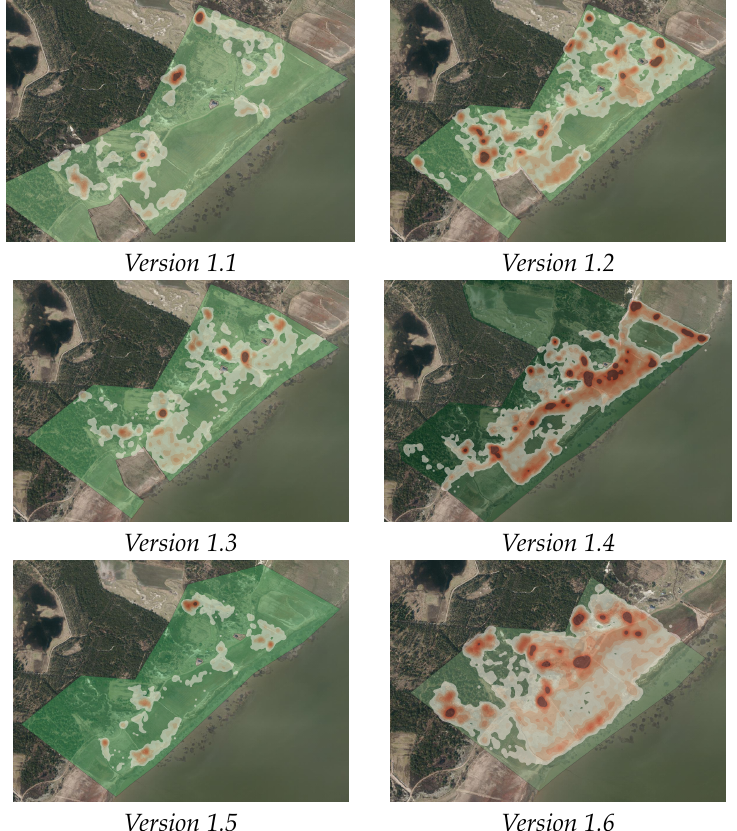
Figure A6. Heatmaps showing the cows’ distribution within the different versions of the virtual enclosure during period 1. The light green area represents the area of the virtual enclosure for each